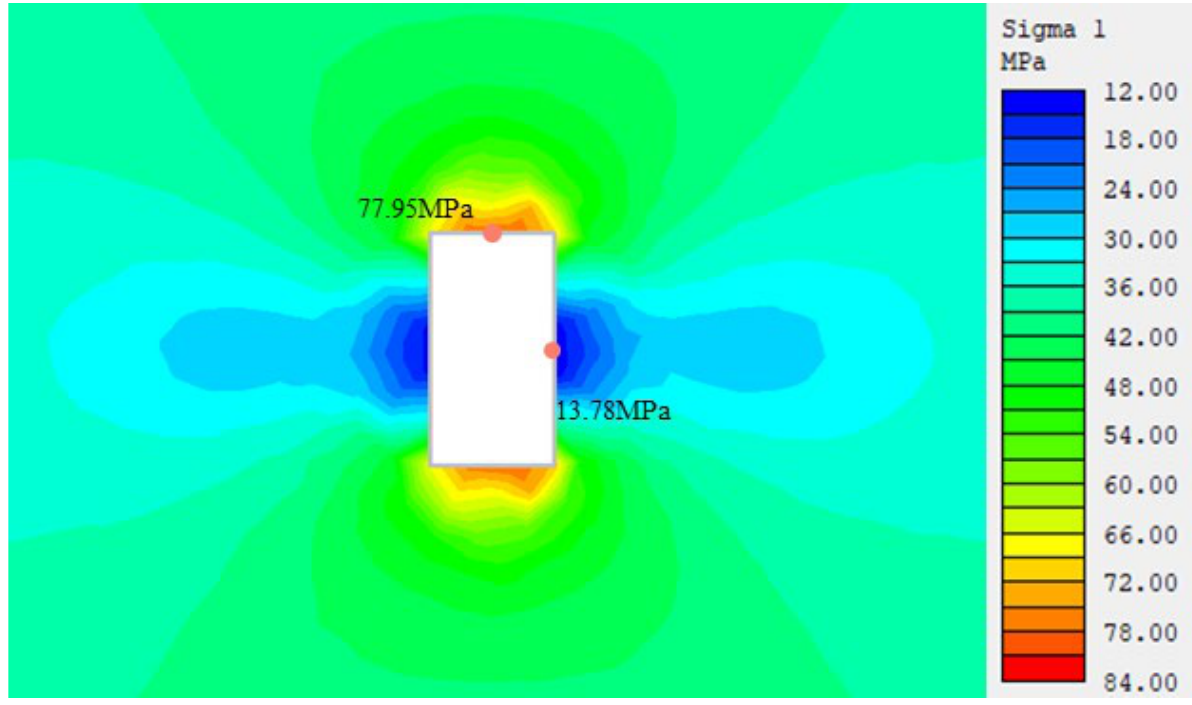
Figure 11. Mining-induced stress solution results.